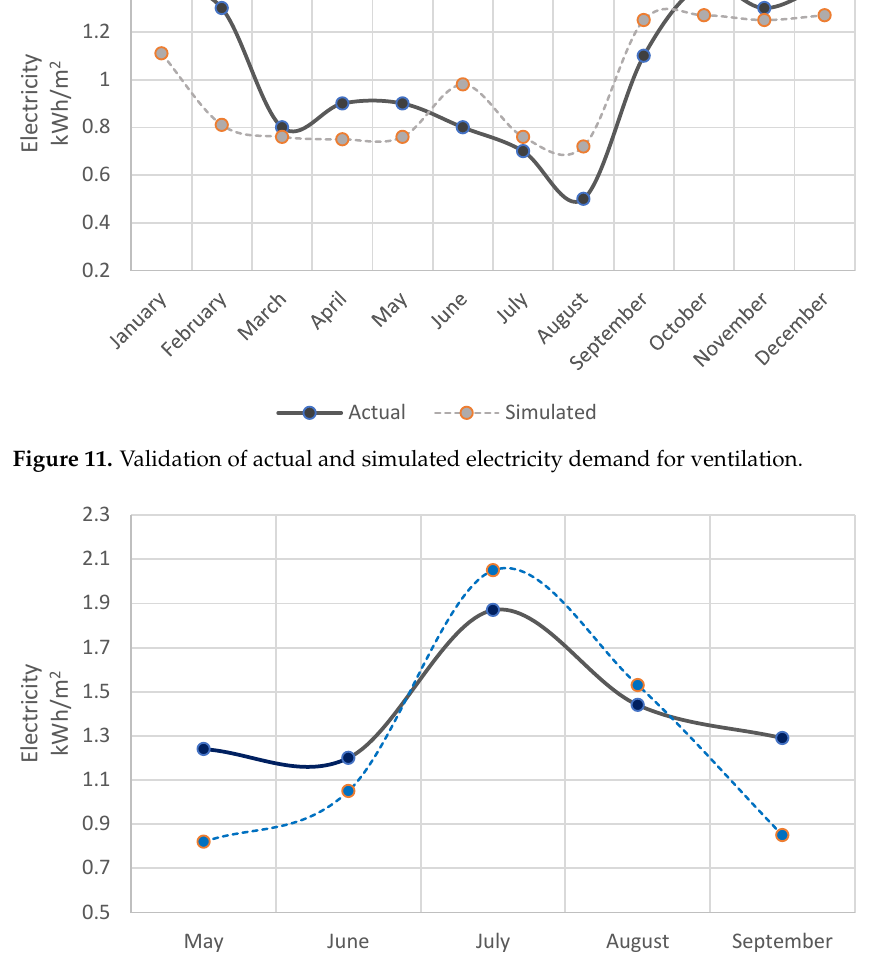
Figure 12. Validation of the actual and simulated results of electricity for air cooling.